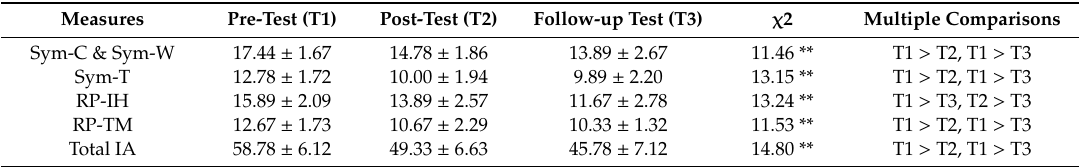
Table3. ComparisonoftheDi ff erencesamongPre-test, Post-testandTrackingScoresintheExperimental Group (x ± s).